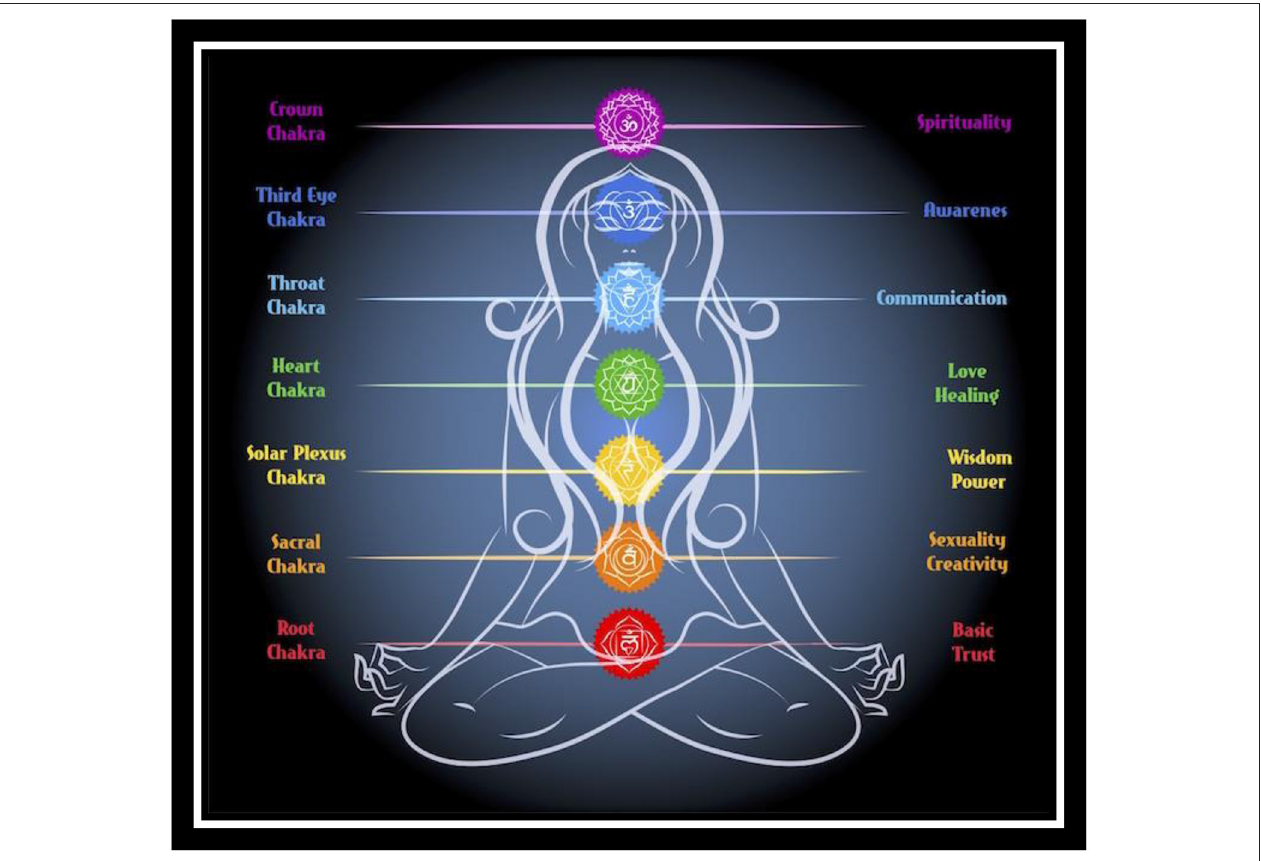
FIGURE 1 | We explore how palates link humans with foodscapes, landscapes, heartscapes, and thoughtscapes. Our reflections have parallels with the seven chakras or energy centers of the body. The root chakra is the foundation, akin to foodscapes nourishing humans. The sacral chakra, which governs sexual energy and creativity, links foodscapes with activities in landscapes. The solar plexus chakra, our ability to feel in control of our life, reflects our relationships with the landscapes we inhabit. The heart chakra is the bridge between the lower chakras (associated with physicality) and the upper chakras (associated with spirituality). This chakra reflects our ability to give and receive love, the basis for our capacity to nurture plants, animals, and people. The throat chakra gives voice to the heart chakra: when we are grounded in the other six chakras, we express ourselves clearly and truthfully. The third eye chakra is awareness gained through the non-cognitive, intuitive, inclusive facets of our being, as opposed simply to the cognitive, rational, analytical details of existence. The crown chakra is transcendent of “I am’s” — and all illusions of duality. It is absolute awareness that “I am” is naught, all knowledge—including what I call “my” self—is liquidated and consciousness is liberated to its true state prior to any identification with physical form and